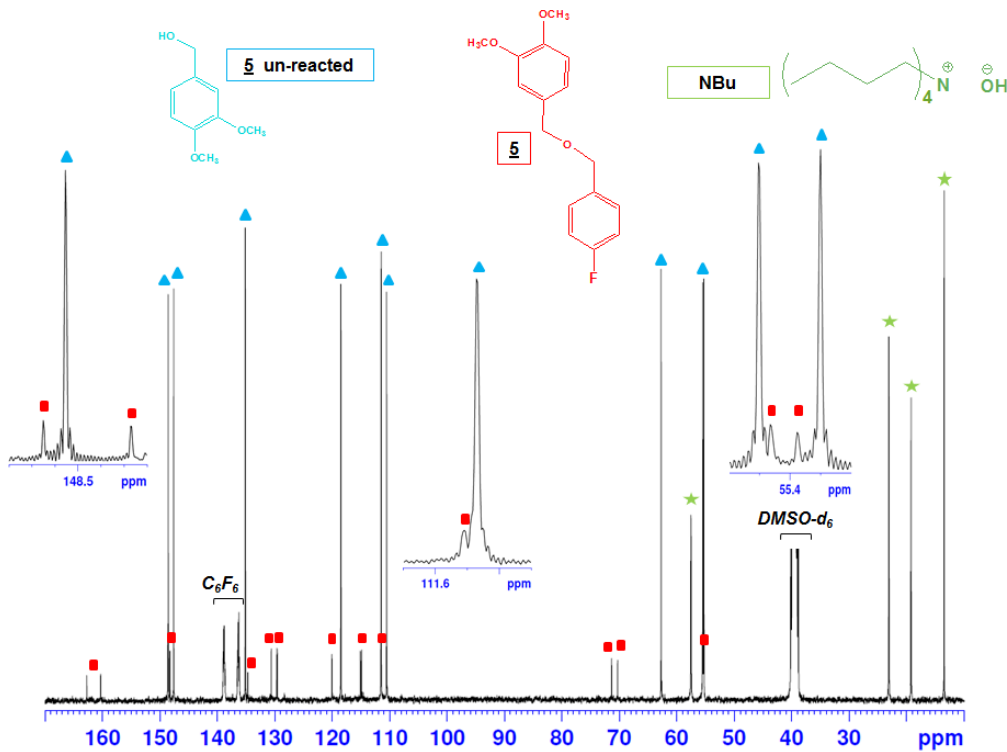
Figure 6. 13 C-NMR spectra of the mixture resulting from the fluorobenzylation of veratryl alcohol ( 5 ) in DMSO-d6.